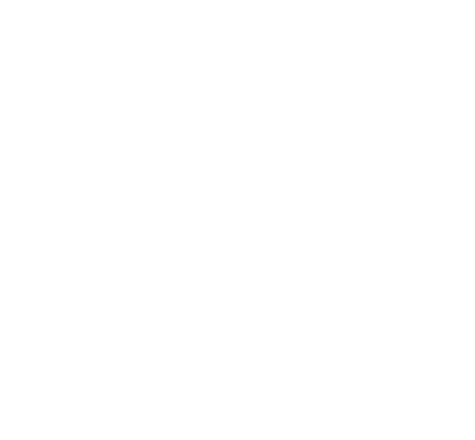
Figure 5. Significant associations of lymphocyte-to-monocyte ratio with histopathological charac- teristics of bladder cancer. A graphically displayed significant difference in PNI between patients with and without LVI is given in Figure 6.